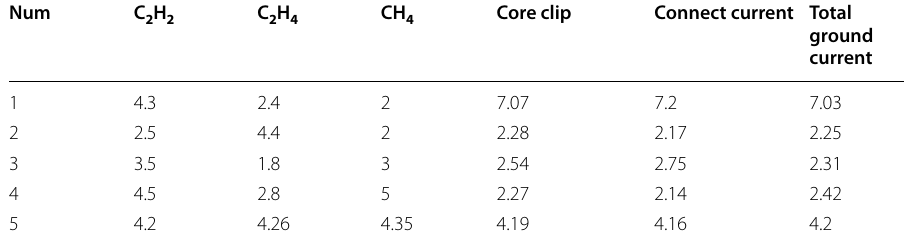
Table 8 Calculate the chromatographic data of 10 sets of transformers Num C 2 H 2 C 2 H 4 Core clip Connect current Total